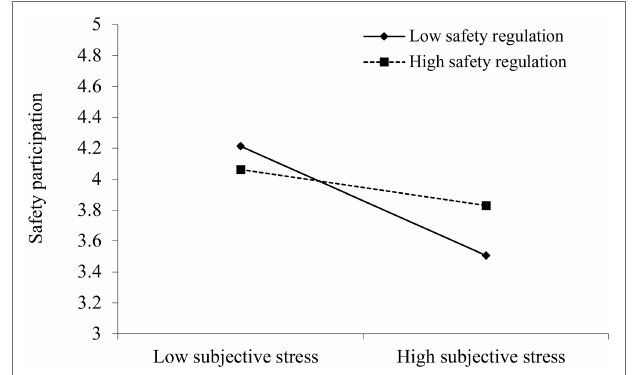
FIGURE 4 | Moderation effect of perceived safety regulation on relationship between psychological stress on safety